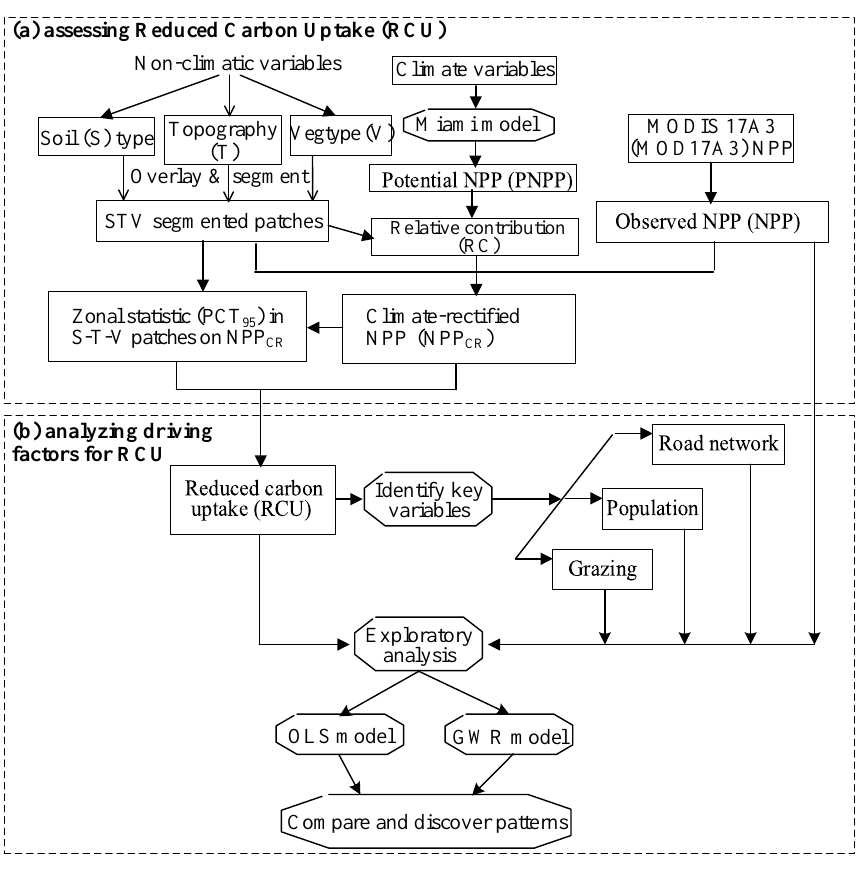
Figure 2. Flowchart of the study.